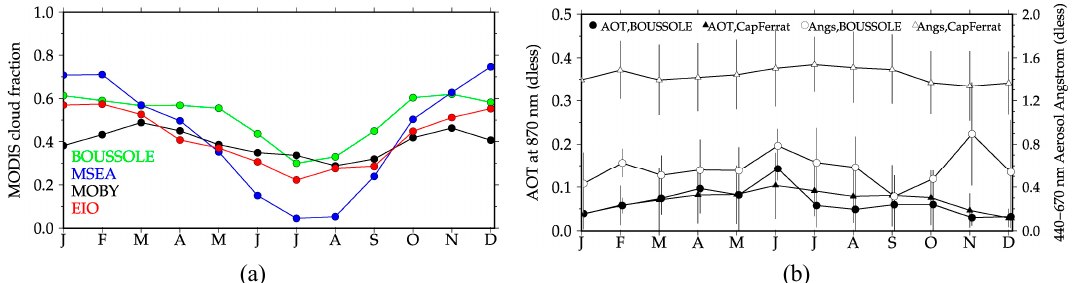
Figure 8. (a) Average seasonal cycles of the cloud fraction (moderate resolution imaging spectroradiometer (MODIS) product [33], average from 2012 to 2015) for the four sites indicated. The curve for the southern hemisphere Eastern Indian Ocean (EIO) site is artificially shifted by 6 months. (b) Average seasonal cycles of the aerosol optical thickness at 865 nm (black symbols) and of the aerosol Angstrom exponent (open symbols), both at the Cap Ferrat coastal AERONET station (triangles) and at the offshore BOUSSOLE site (circles).